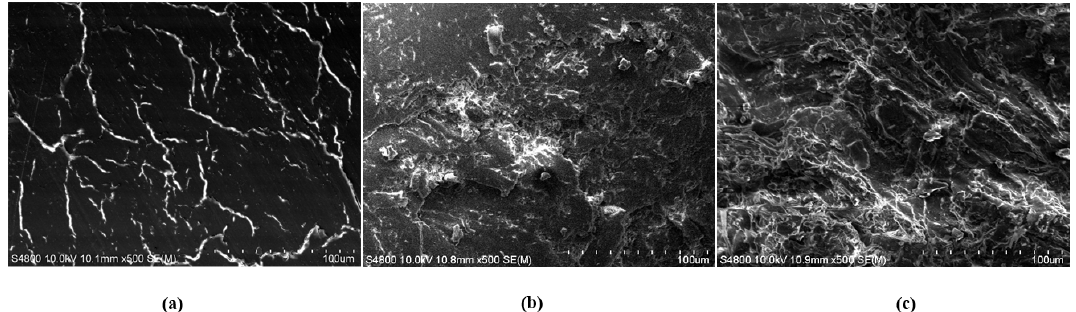
Figure 10. Circular surface morphology of φ 6 mm biomass pellet: ( a ) d = 6.08 mm, D = 1.820, ( b ) d = 6.84 mm, D = 1.6, ( c ) d = 7.41 mm, D = 1.536.